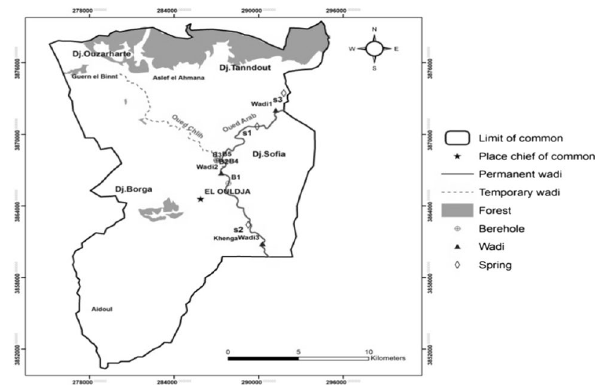
Fig. 3 Inventory map of study